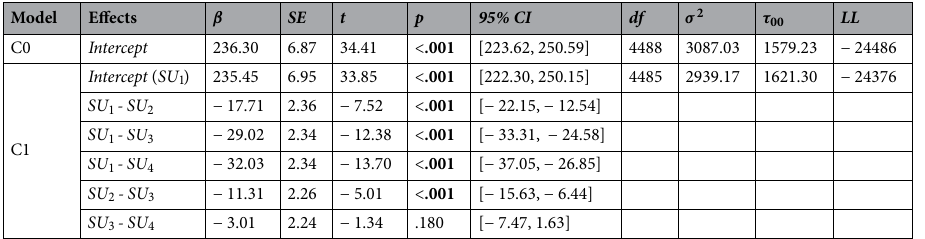
Table 3. LMM analysis of the effect of expected surprise on the visually-guided saccade reaction time. β fixed 2 effect coefficient, LL Log-likelihood, σ variance of level-1 residual errors, τ 00 variance of level-2 residual errors. Significant values are in bold.